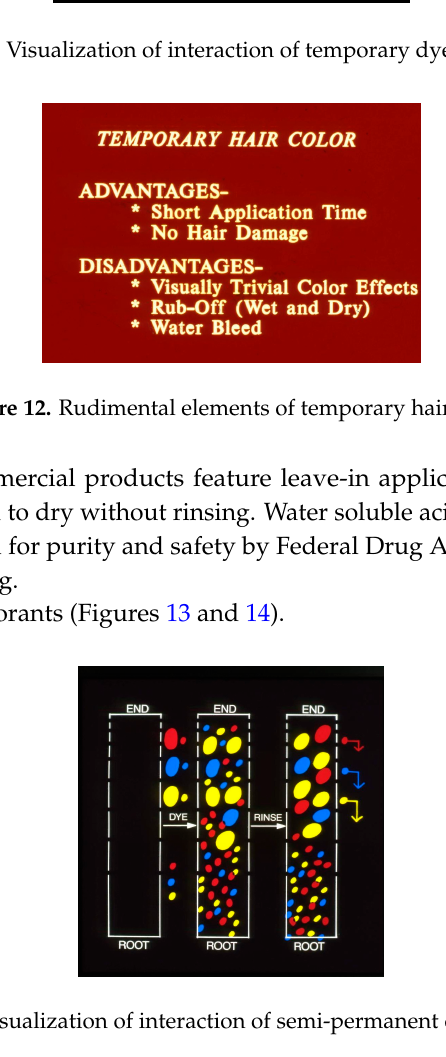
Figure 11. Visualization of interaction of temporary dyes with hair.